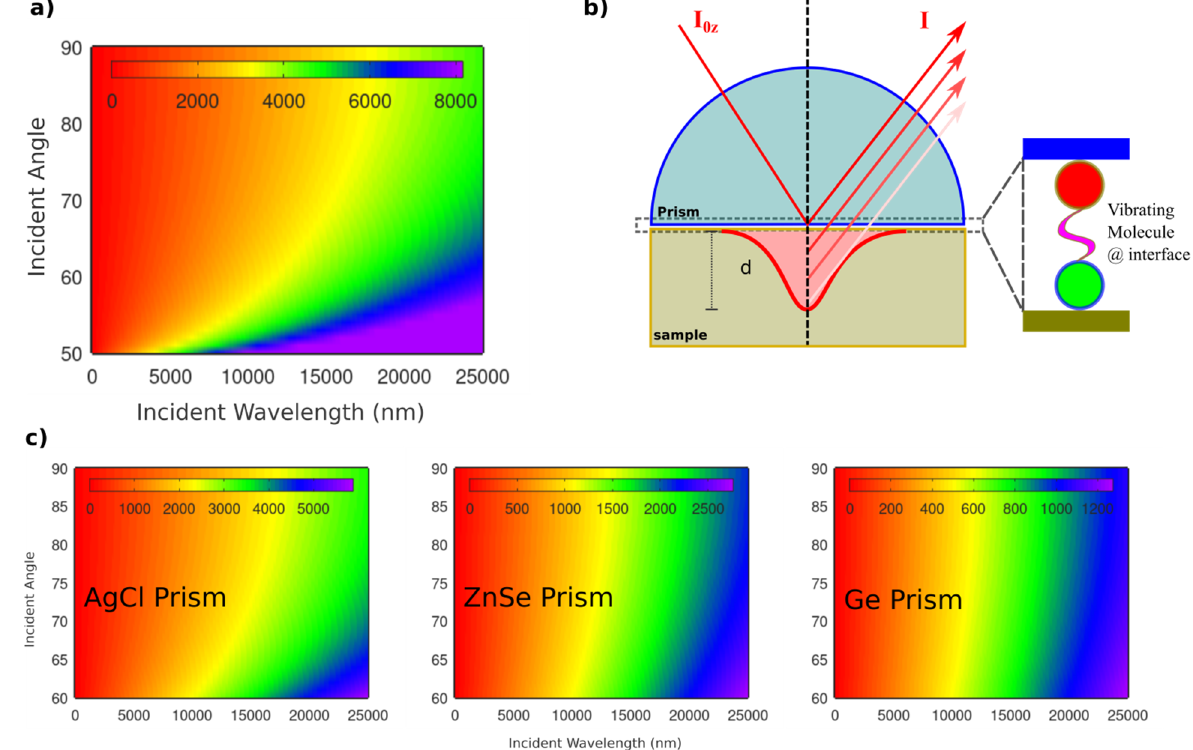
Figure 5. Relationship between incident angle (higher than critical angle) and the utilized wavelength in the IR region between water “assuming No IR absorption” and air interface, showing the evanescent field at the interface. ( a ) Water-air interface. ( b ) Schematic representation for generation evanescent field at interface. ( c ) Effect of prism materials on the penetration depth of the evanescent field at interface.